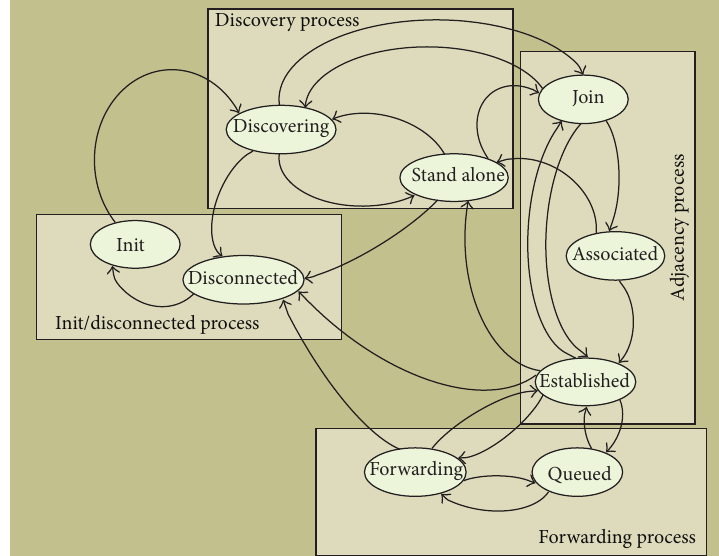
Figure 5: Finite-state machine for multimedia wireless ad hoc cluster